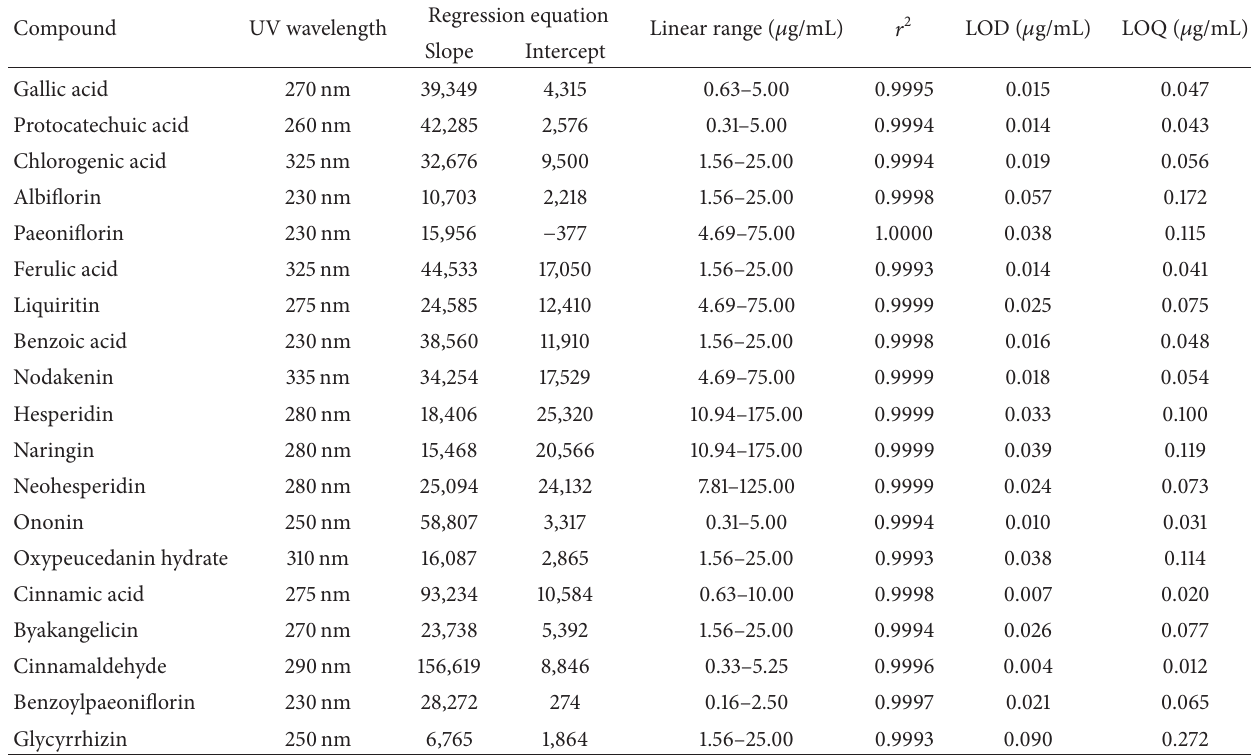
Table 2: Regression, correlation coefficient ( 𝑟 2 ), LOD, and LOQ of the marker compounds of